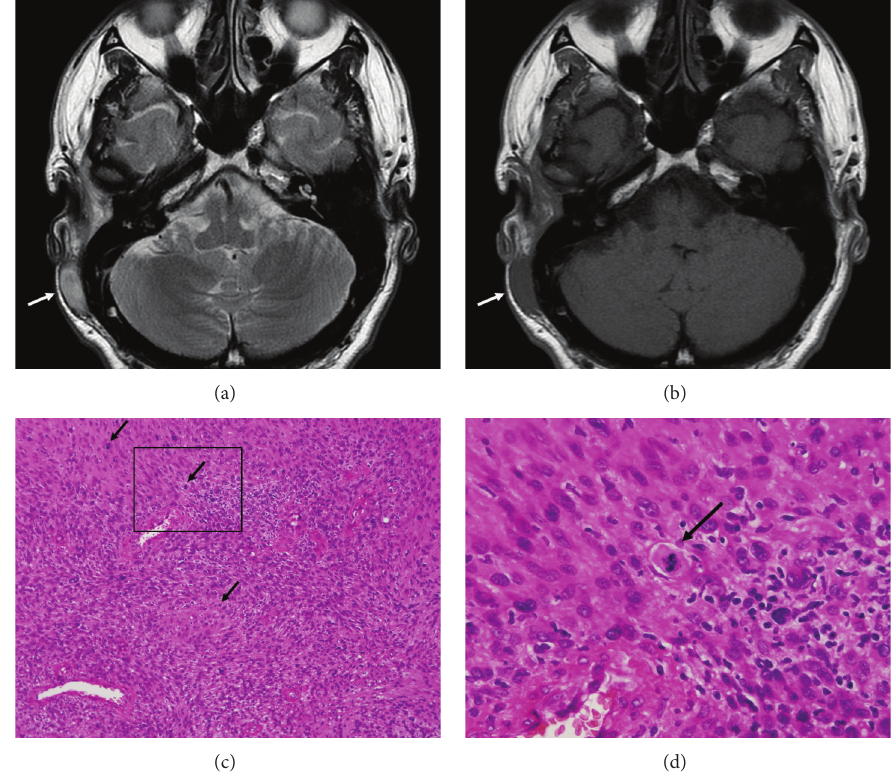
Figure 1: MPNST of the right postauricular region. (a, b) Axial T1- and T2-weighted MRI undertaken at the previous hospital shows a right postauricular elliptical tumor (arrow). (c) Photomicrograph of the resected tumor which is composed of spindle cells disposed in sweeping fascicles. The mitotic figures present are characteristic of malignancy (arrows) (Haematoxylin and Eosin stain; original magnification × 200). (d) Photomicrograph at higher power showing mitosis (arrow) (Haematoxylin and Eosin stain; original magnification ×